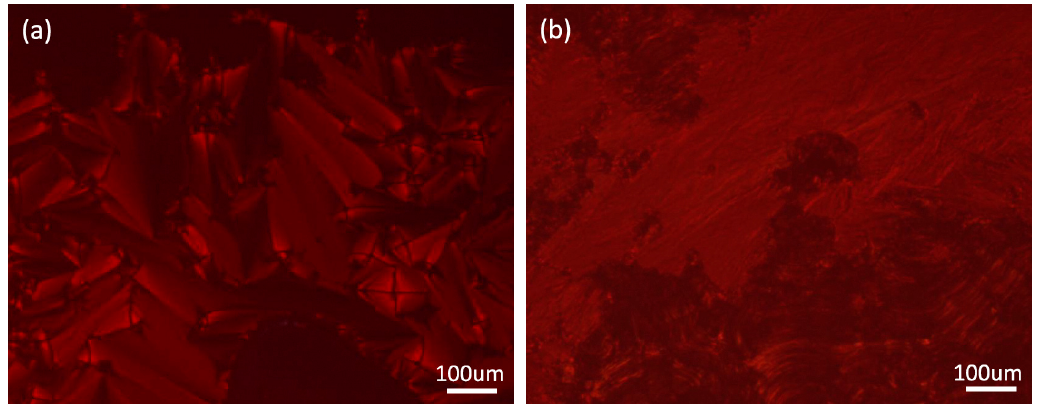
Figure 6. Fan-shaped texture ( a ) and crystalline phase ( b ) of BTC6 observed by a polarized microscope at 222.3 °C and 170.1 °C, respectively, during the cooling process.